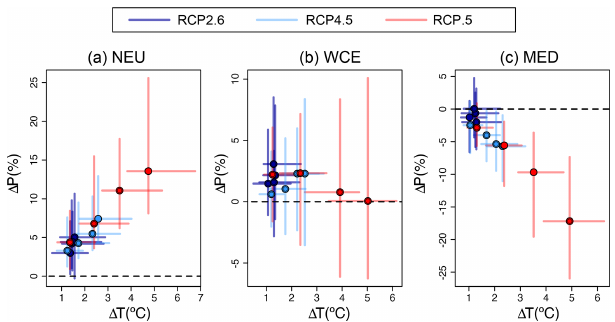
Figure 6. Illustrative example of the use of reference regions and aggregated CMIP5 datasets: regional mean changes in annual mean temperature and precipitation for three European regions (NEU, WCE and MED) for four future periods (2021–2040, 2041–2060, 2061–2080, 2081–2100), as obtained from CMIP5 projections. Changes are absolute for temperature and relative for precipitation. Horizontal and vertical error bars represent ± 1 standard deviation from the mean calculated across the ensemble of included models. The script to generate this figure for all the 61 land and ocean re- gions (as well as the global results) from the aggregated and ready- to-use CMIP5 datasets is available at the ATLAS GitHub and can be adapted to produce similar results for alternative datasets (e.g.